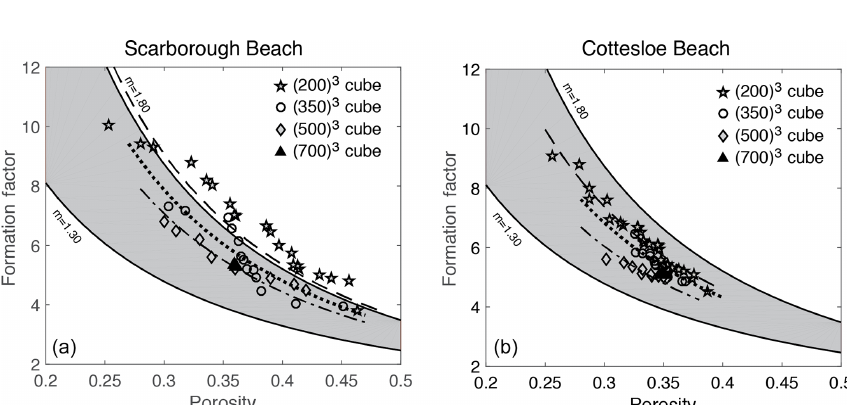
Figure 11. Formation factor against porosity for each sub-cube size of 200 3 , 350 3 , 500 3 , and 700 3 from (a) Scarborough Beach samples and (b) Cottesloe Beach